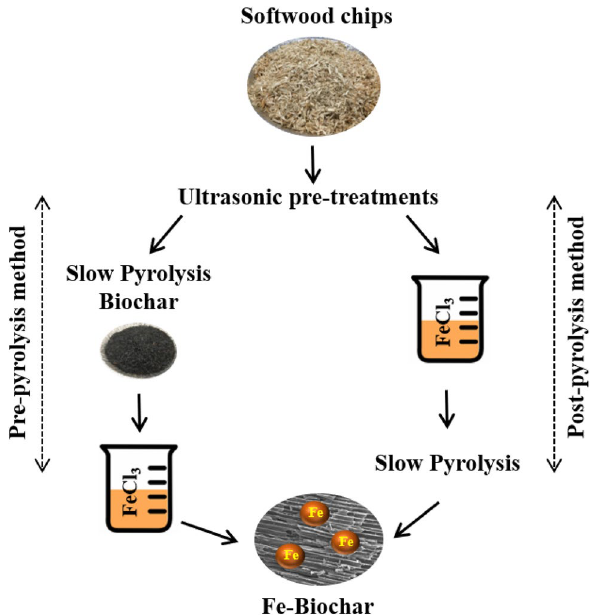
Fig. 2 Schematic representation of Fe-impregnation